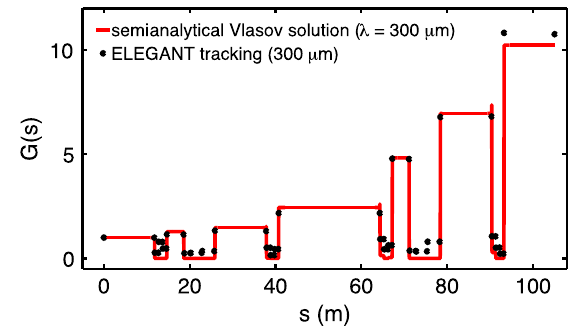
FIG. 9. Steady-state CSR gain functions G ð s Þ for the JLEIC CCR lattice. Note here that λ ¼ 300 μ m for both the semi- analytical solution and ELEGANT tracking. In elegant tracking we impose an initial density modulation amplitude 0.2% on a flattop density